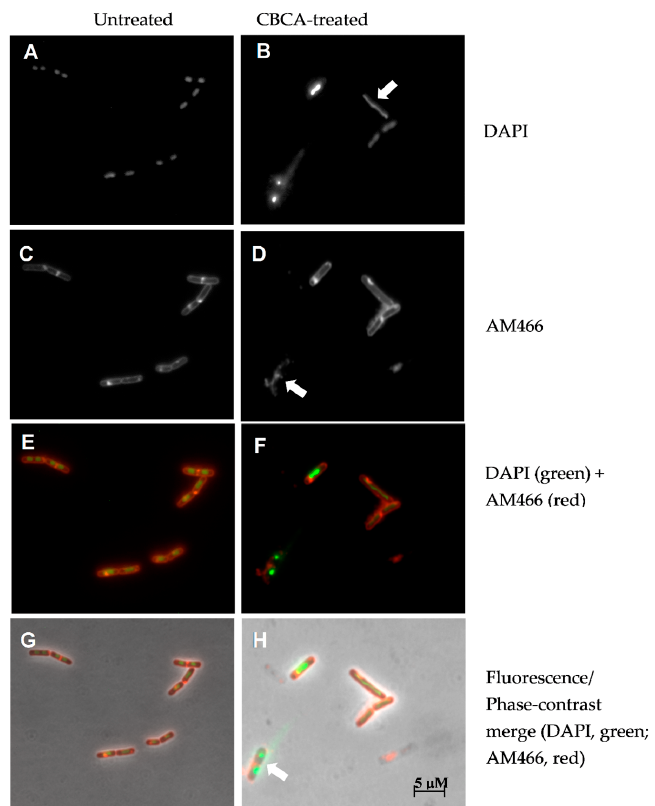
Figure 5. Impact of CBCA treatment on B. subtilis cell wall integrity. B. subtilis cells in exponential phase (OD 600 0.1–0.3) were not treated ( A , C , E , G ) or treated with CBCA at 0.4 × MIC ( B , D , F , H ) as well as the lipid-staining fluorescent molecule AM466 ( C – F ). After 30 min, DAPI (200 ng / mL) was added, cell suspensions deposited on agarose pads for fluorescence or phase contrast microscopy. White arrows indicate long-spindle shaped nucleoids and smearing of nuclear material (row 1); abrogation of the lipid membrane (row 2); maintenance of rod-shape of Bacillus simultaneous to degradation of nucleoids and lipid membrane (row